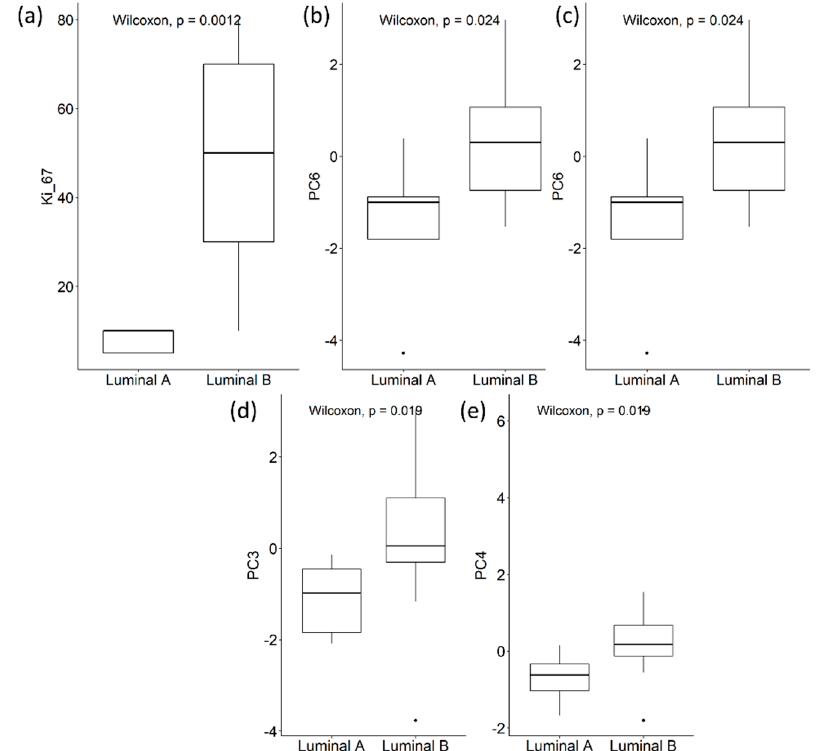
Figure 8. Box Plots for the tumor subtypes (i.e., Luminal A and Luminal B). ( a ) Ki-67; ( b ) PC6 from the non-normalized dataset; ( c ) PC6 from z-score dataset; ( d ) PC3 from the quantile dataset; ( e ) PC4 from the quantile dataset.